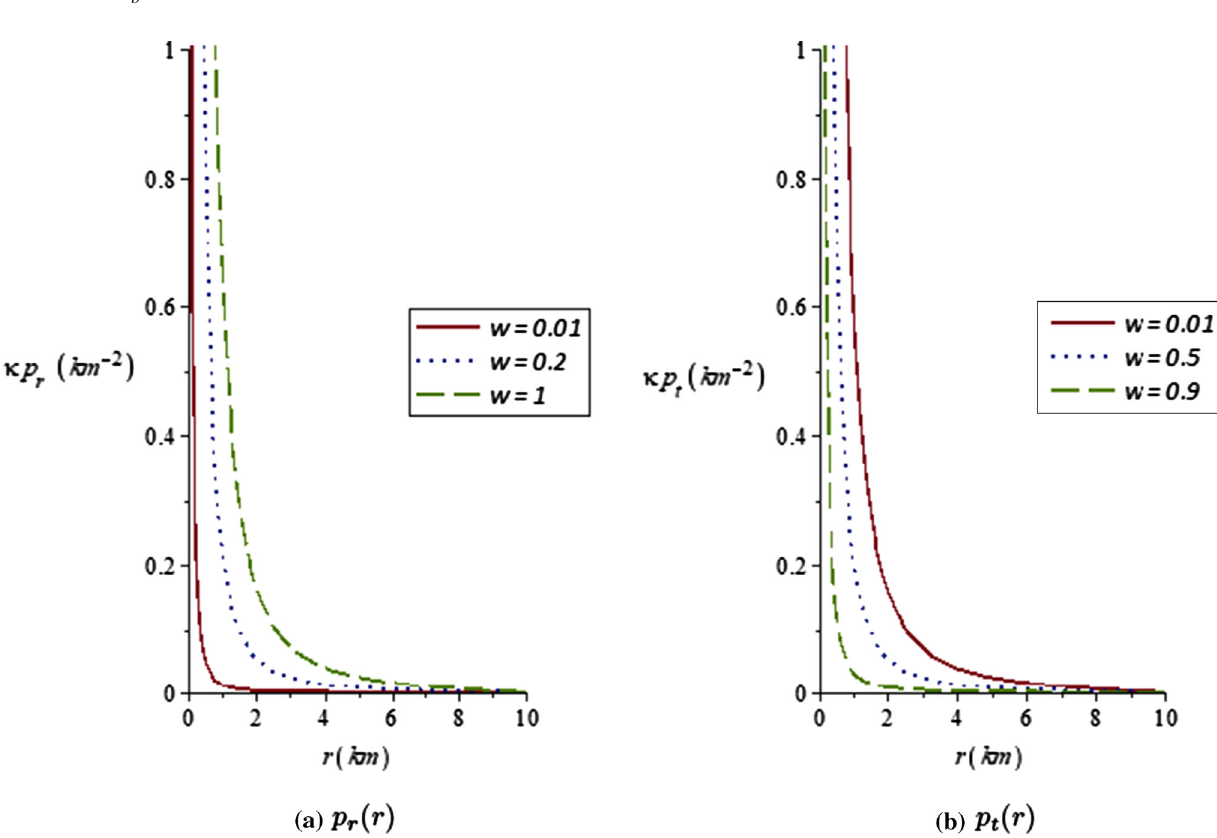
Fig. 1 The radial ( a ) and tangential ( b ) pressures as a function of the radial distance r for k = 1, α = 4, r b = 10 km and some different ω values. (The energy density c 2 ρ is proportional to the radial pressure as p r = ω c 2 ρ